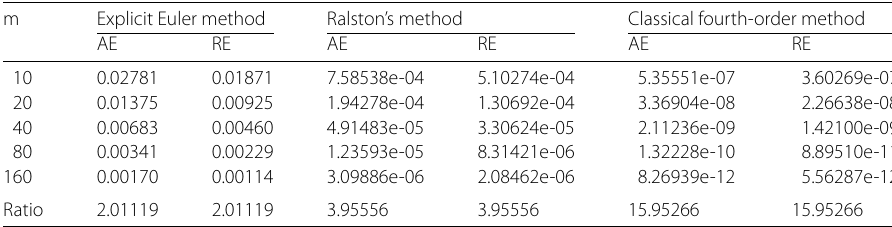
Table 1 The errors Runge–Kutta methods for (11)